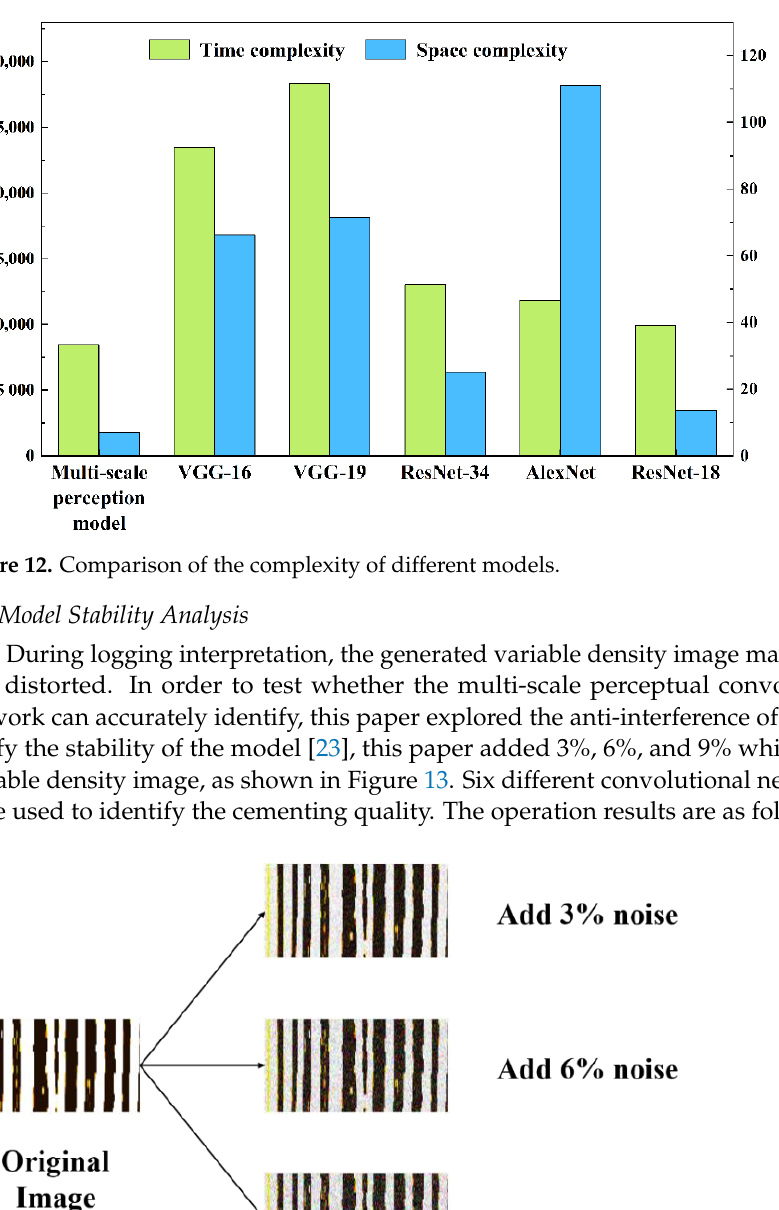
Figure 11. Comparison of accuracy of different models.